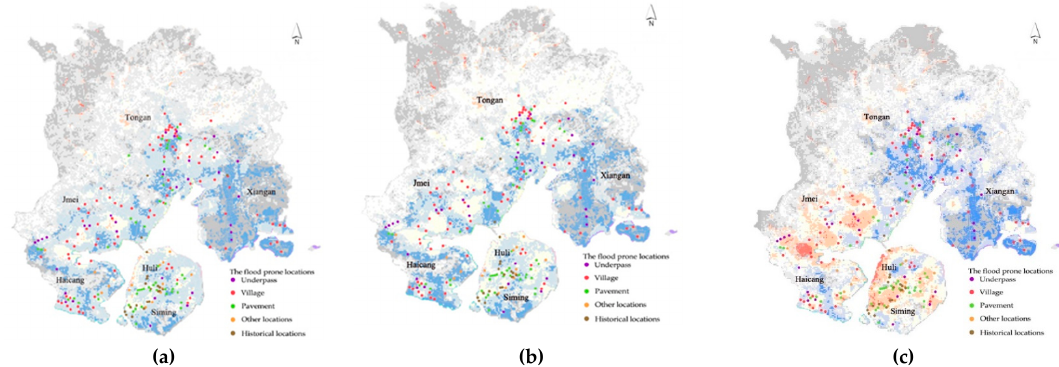
Figure 8. The flood prone locations under different scenarios in Xiamen: ( a ) the flood prone locations under the average annual precipitation scenario; ( b ) the flood prone locations under the average precipitation during the flood season scenario; and ( c ) the flood prone locations under the precipitation during the typhoon scenario.